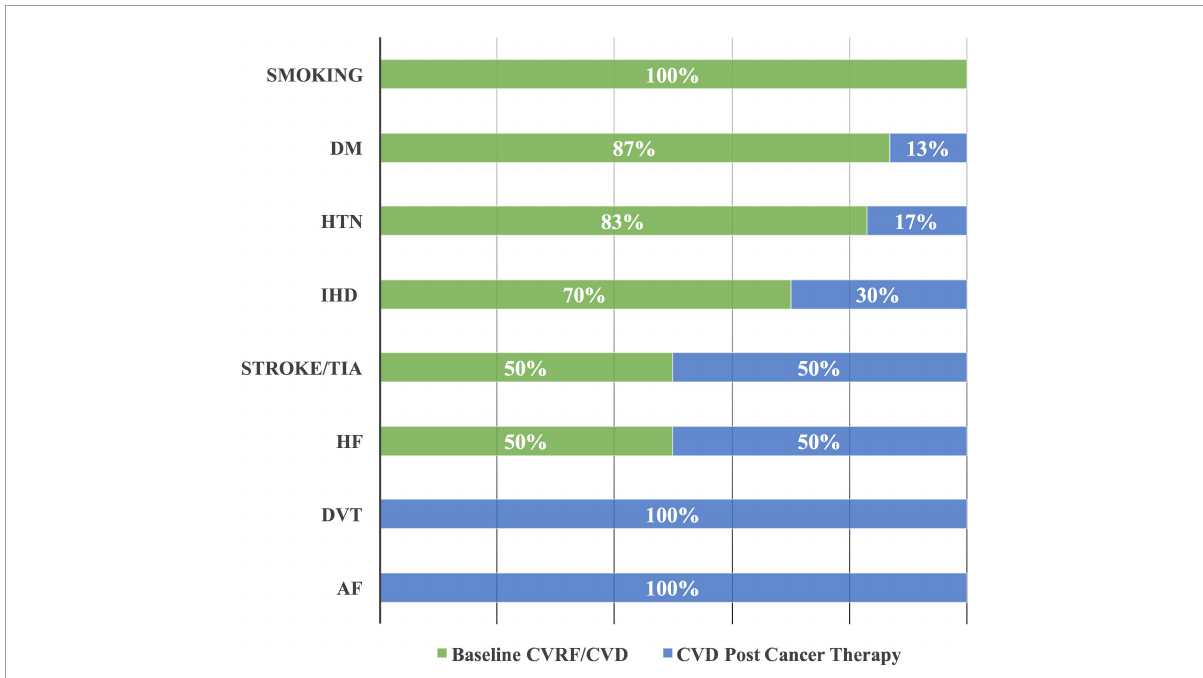
FIGURE3 Cardiovascular risk factor/cardiovascular disease at baseline and post-initiation of cancer therapy. The majority of DM, HTN, and IHD are documented at the baseline as CVRF and CVD among patients with cancer. AF, atrial fibrillation; CVD, cardiovascular disease; CVRF, cardiovascular risk factor; DM, diabetes mellitus; DVT, deep vein thrombosis; HF, heart failure; HTN, hypertension; IHD, ischemic heart disease; and TIA, transient ischemic attack.